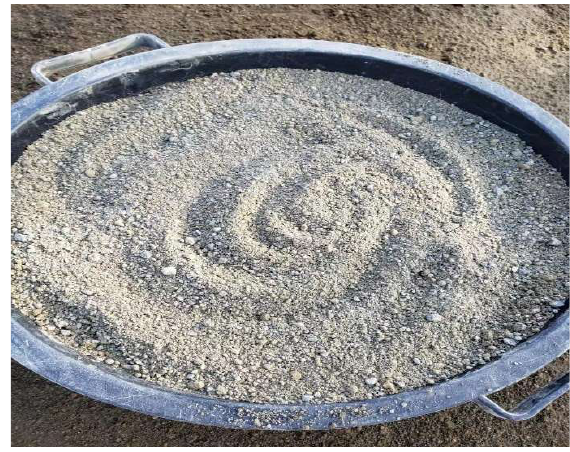
Figure 3. Volcanic ash material sample.